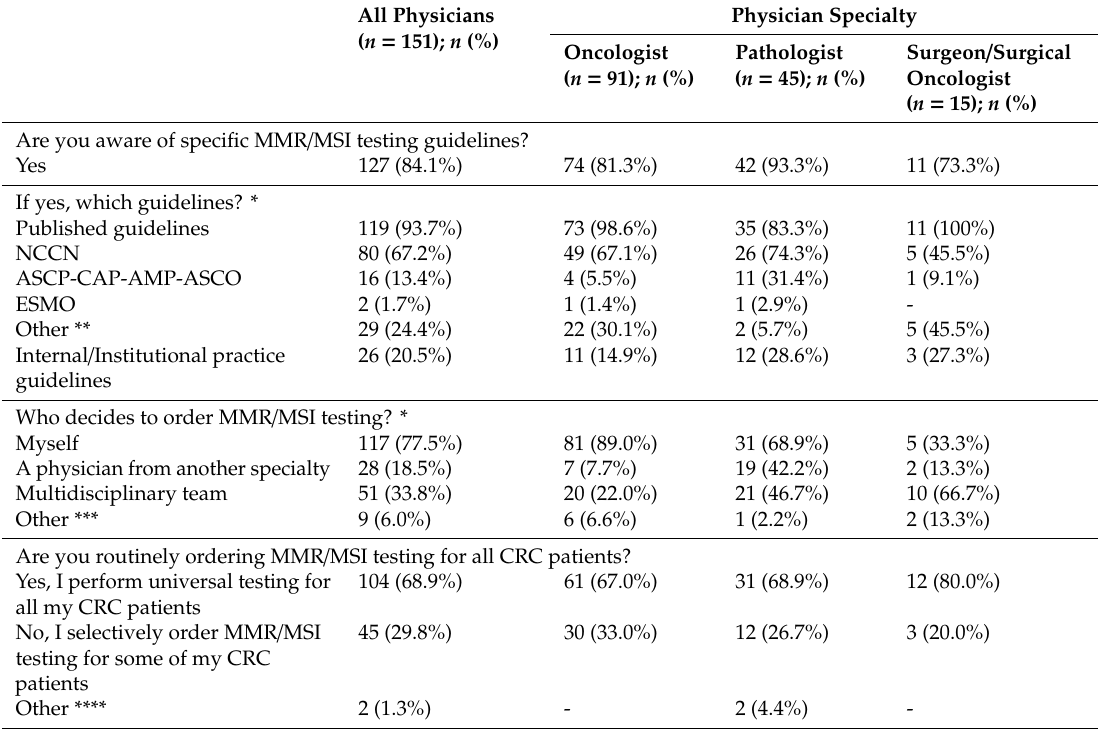
Table 2. MMR / MSI testing guideline awareness and